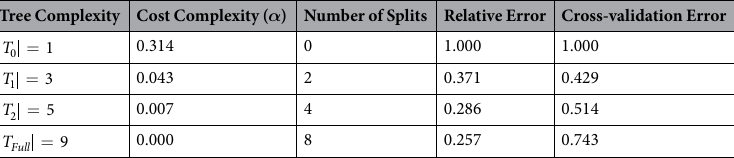
Tree Complexity Cost Complexity ( α ) Number of Splits Relative Error Cross-validation Error